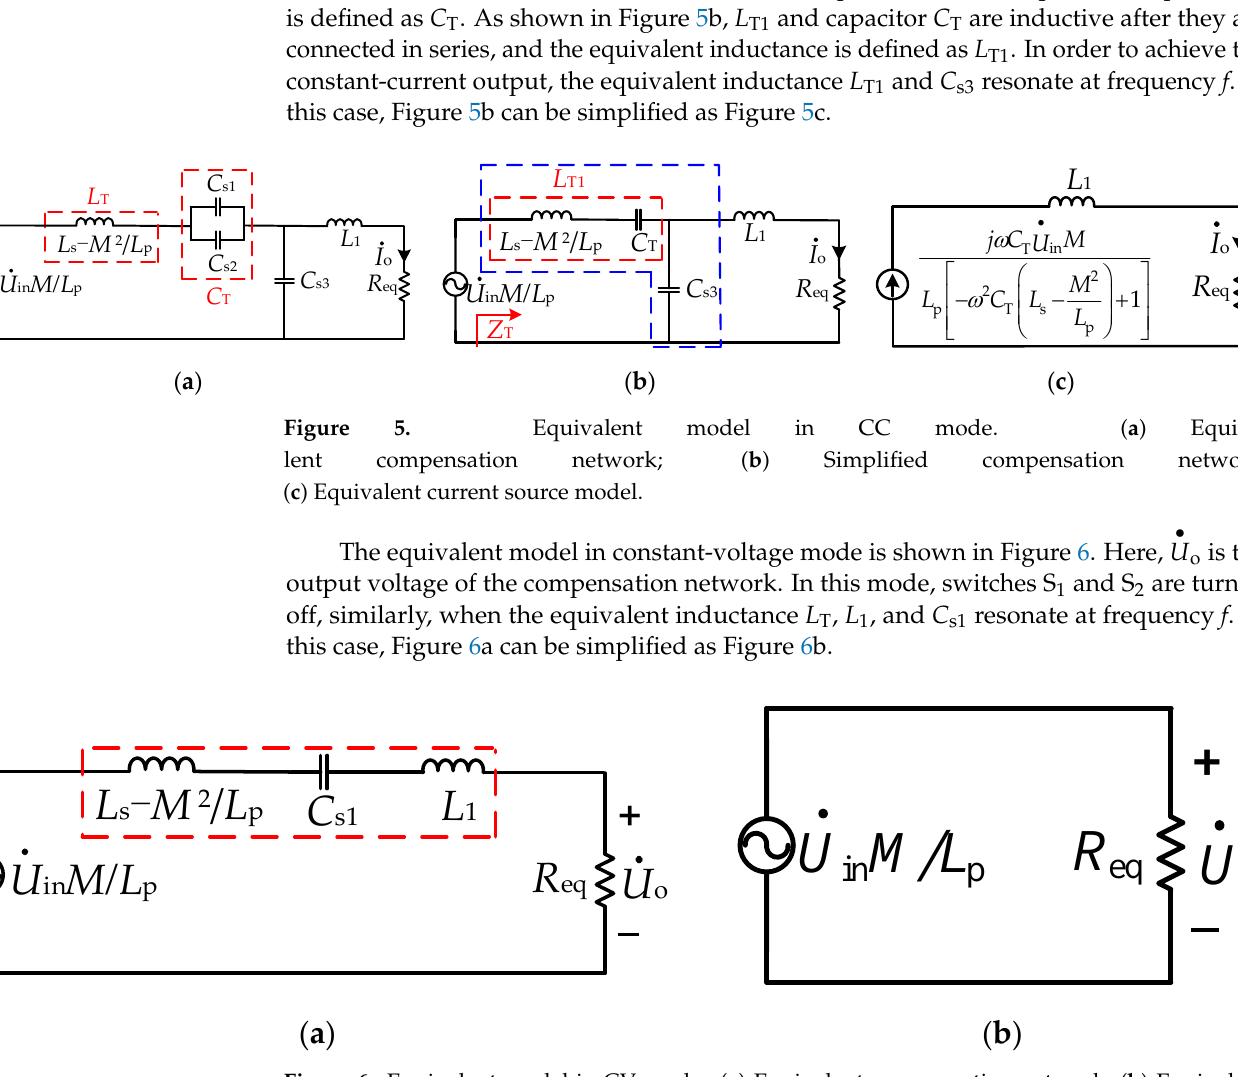
Figure 6. Equivalent model in CV mode. ( a ) Equivalent compensation network; ( b ) Equivalent voltage source model.